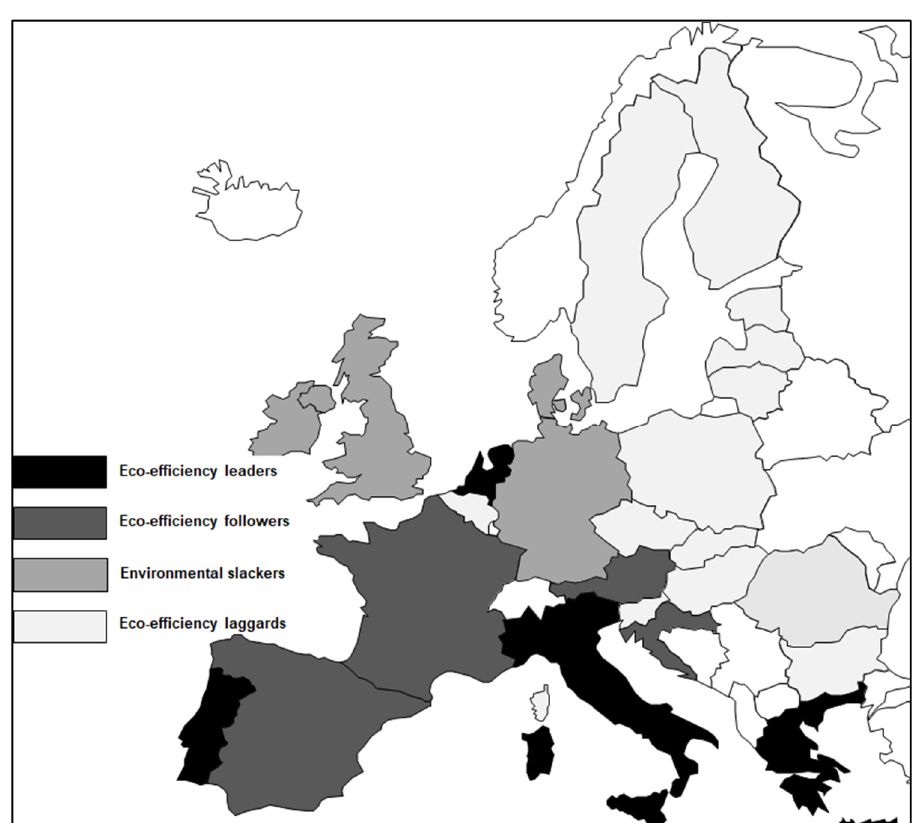
Figure 5. Eco-efficiency of agriculture in EU (2019). Source: own study.